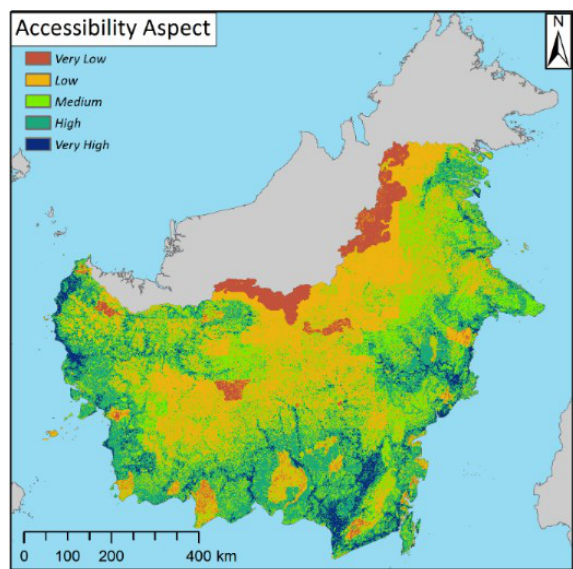
Figure 3 . Accessibility Aspects